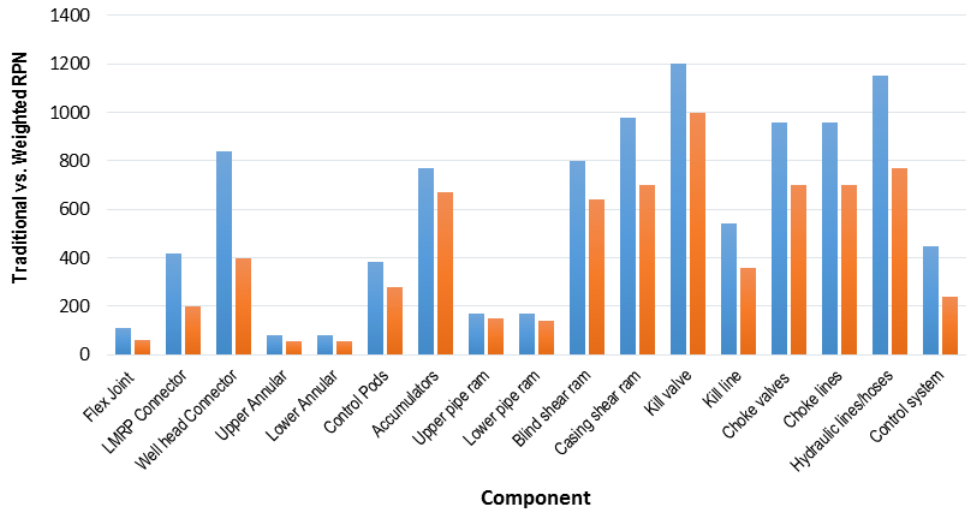
Figure 4. RPN values obtained from the traditional FMEA technique ( ∎ ) versus weighted RPN values obtained by the propose method ( ∎ ) Figure 5. Weighted RPN values for shallow-water ( ∎ ) and deep-water ( ∎ ) cases.